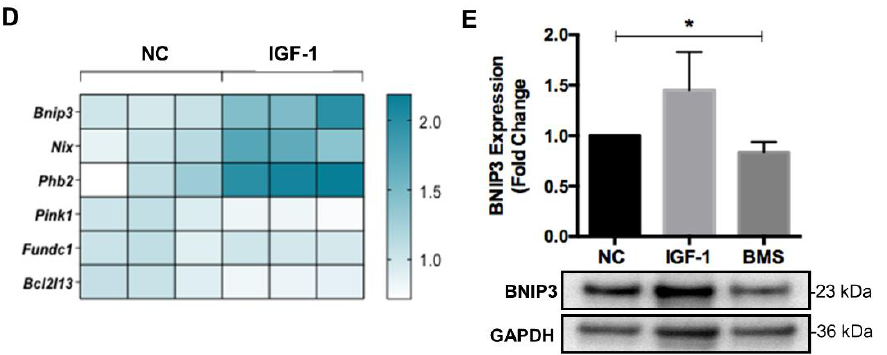
Figure 4. IGF-1 signaling regulates mitophagy during myogenic differentiation. ( A ) Representative immunoblots and quantitative analysis of SQSTM1/p62 (p62), ATG5, and GAPDH in differentiating cells. ( B ) Representative immunoblots and quantitative analysis of LC3B and GAPDH in differentiating cells with or without chloroquine (CQ) treatment. In the experiments for monitoring the autophagic flux, cells were treated with 50 µ M CQ for 4 h as CQ treatment leaded to LC3B-II aggregation. The autophagic flux was analyzed through the ratio of LC3B-II expression in CQ-treated and untreated cells. ( C ) Representative fluorescent images and quantitative analysis of colocalization (yellow) in ad-GFP-LC3 (green) transfected cells and stained with anti-TOMM20 (red) at day 1 of differentiation. Scale bar = 10 µ m. ( D ) mRNA expression of mitophagy receptors in differentiating C2C12 myoblasts with or without treatment of IGF-1. ( E ) Representative immunoblots and quantitative analysis of BNIP3 and GAPDH in C2C12 cells after 3 days of differentiation. Data represent means ± SD. * p < 0.05 and ** p < 0.01.